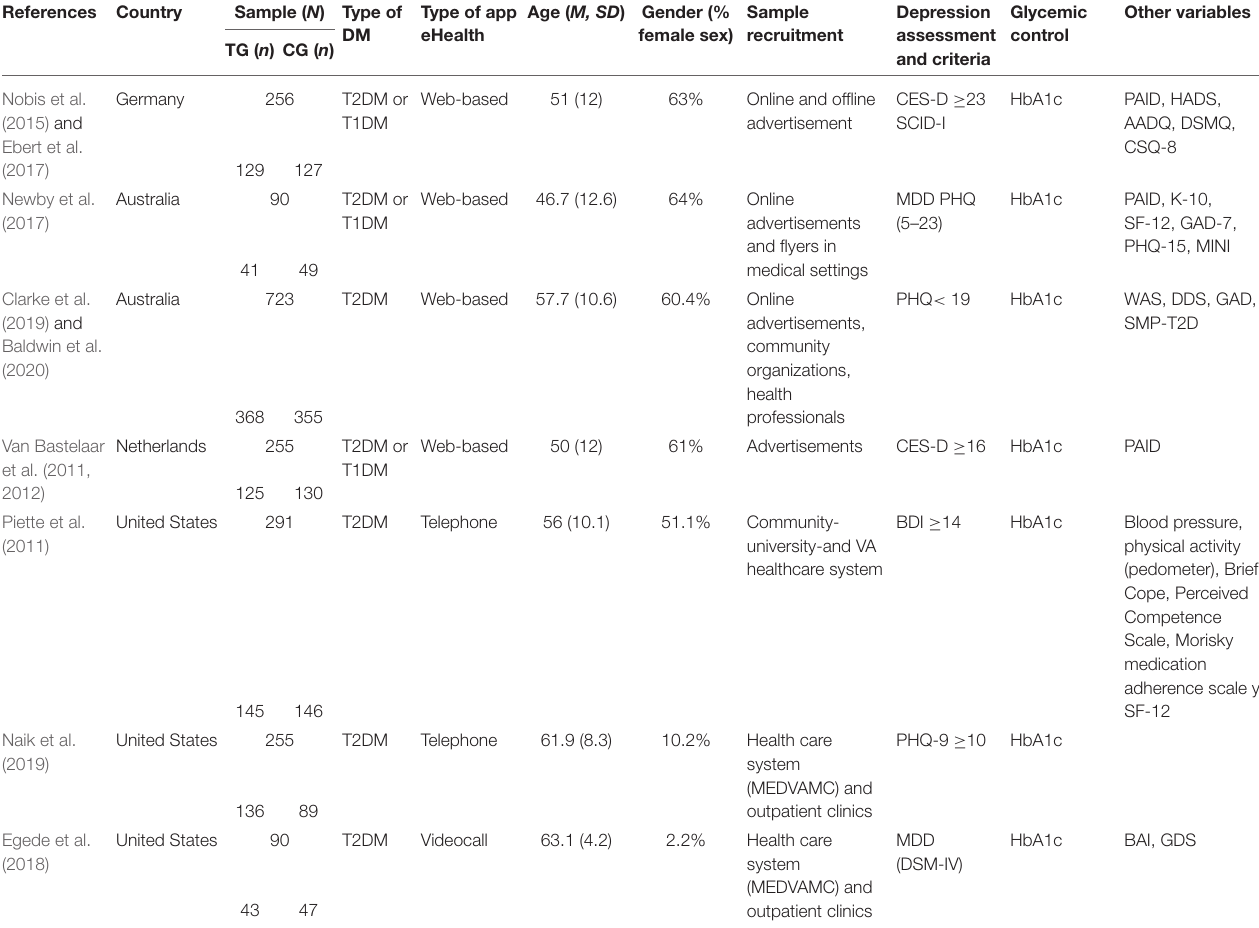
TABLE 1 | Characteristics of the included studies according to the type of eHealth